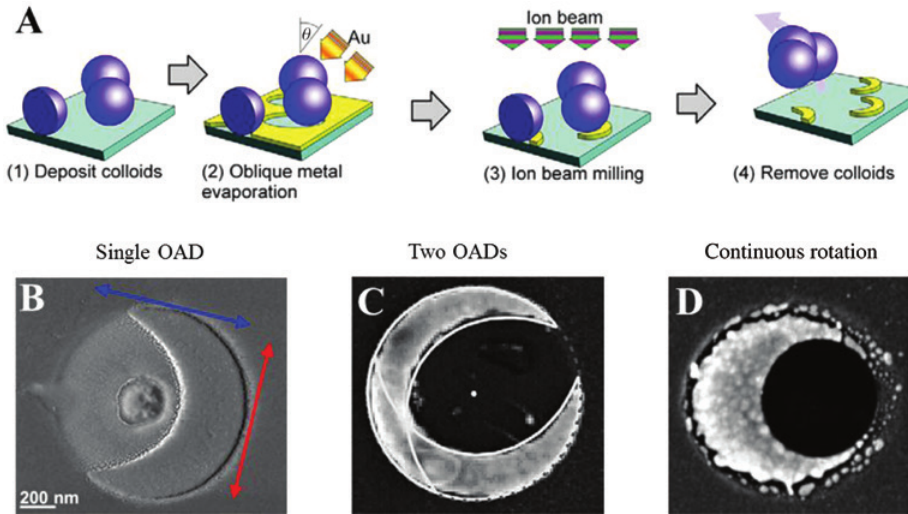
Figure 11: Nanocrescents fabricated by SSL. (A) Scheme for the typical fabrication process of crescents [111]. (B) SEM image of a nanocrescent fabricated by a single OAD. The red and blue arrows show the long and short axis, respectively [112]. (C) SEM image of stacked nanocrescent fabricated by two OADs [111]. (D) SEM image of a nanocrescent fabricated by continuous rotation